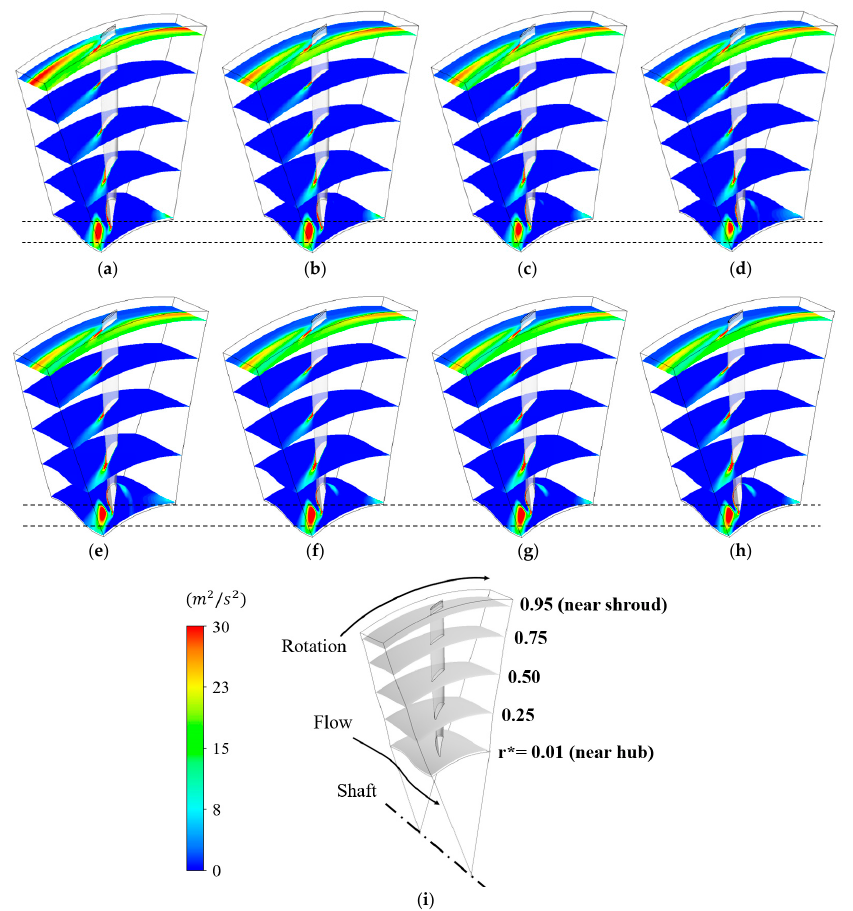
Figure 12. Distribution and range of turbulence kinetic energy on ( i ) the observation planes in a rotating domain for the ( a ) 15%, ( b ) 20%, ( c ) 25%, ( d ) 30%, ( e ) 35%, ( f ) 40%, ( g ), 45%, and ( h ) 50% sets ( 𝛷/𝛷 (cid:3031)(cid:3032)(cid:3046) = 1.0 ).